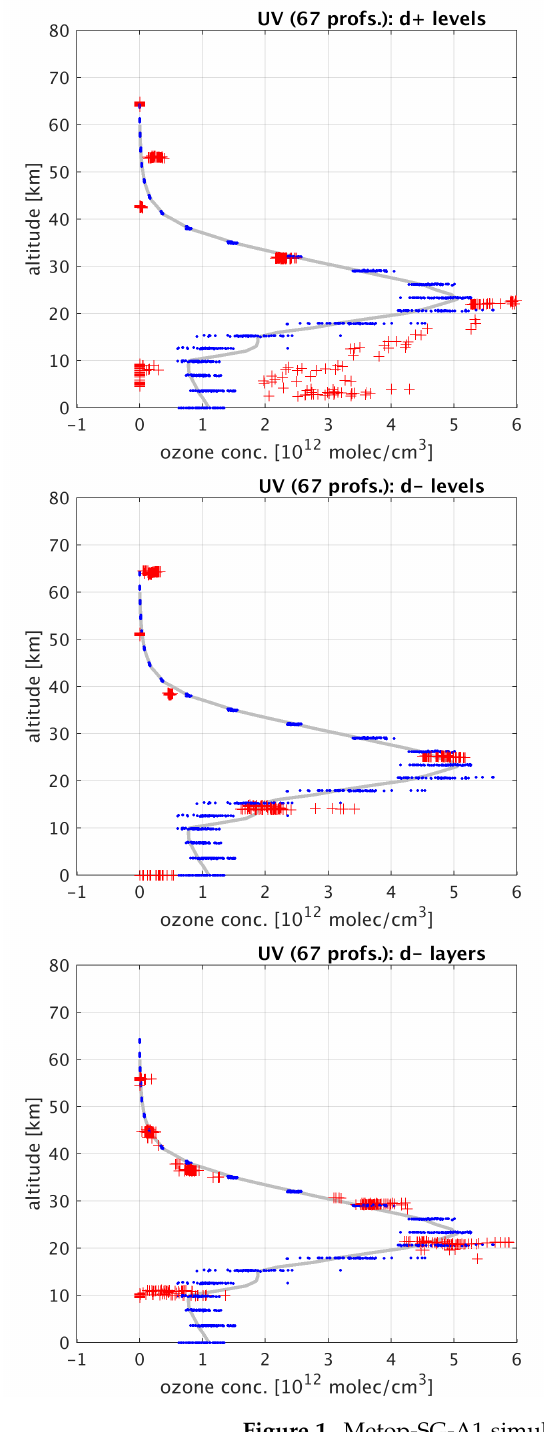
Figure 1. Metop-SG-A1 simulated ozone profile retrievals (blue dots) and deconvoluted profiles (red crosses) from the Sentinel-5 UV ( left ) and IASI-NG TIR ( right ) spectral bands for April 2012 and within 50 km of Izaña. Either the upper ( d + , top) or lower ( d − , middle and bottom) nearest integer of the initial number of retrieval degrees of freedom determines the number of elements in the deconvoluted profile. In the middle panels, these elements are attributed to d − levels, while in the bottom panels, they are attributed to d − layers. Grey lines show the ’true’ ozone profile as the median of MERRA-2 within the same spatiotemporal